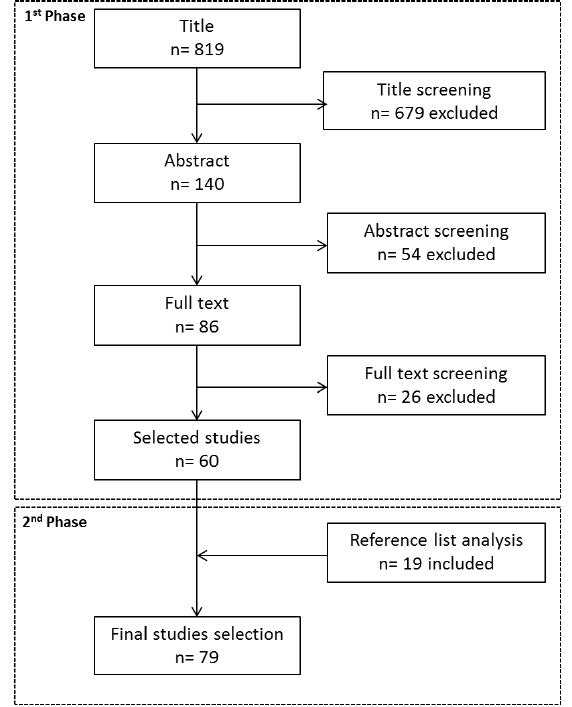
Figure 1. Diagram describing the selection strategy of studies.